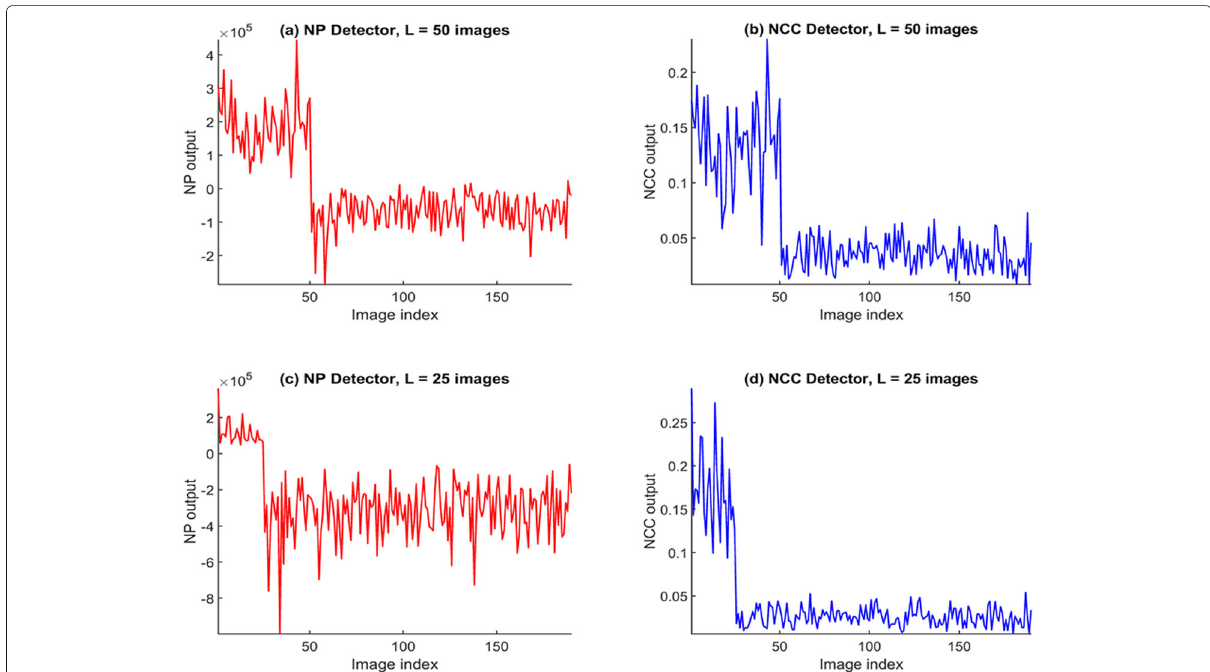
Fig. 6 Detection statistics for the Neyman-Pearson detector (14) (images (a) and (c), the corresponding scale is × 10 5 ) and the Normalized Correlation coefficient detector (19) (images (b) and (d)) on a set of 190 images (Nikon D7000 camera), where the PRNU is estimated from the first 50 images (top row) or the first 25 images (bottom row). From the results, it is clear that the detector is able to identify which images were used to estimate the PRNU, but its performance decreases when more images are employed in the estimation, as the contribution of each individual image gets diluted when larger datasets are considered